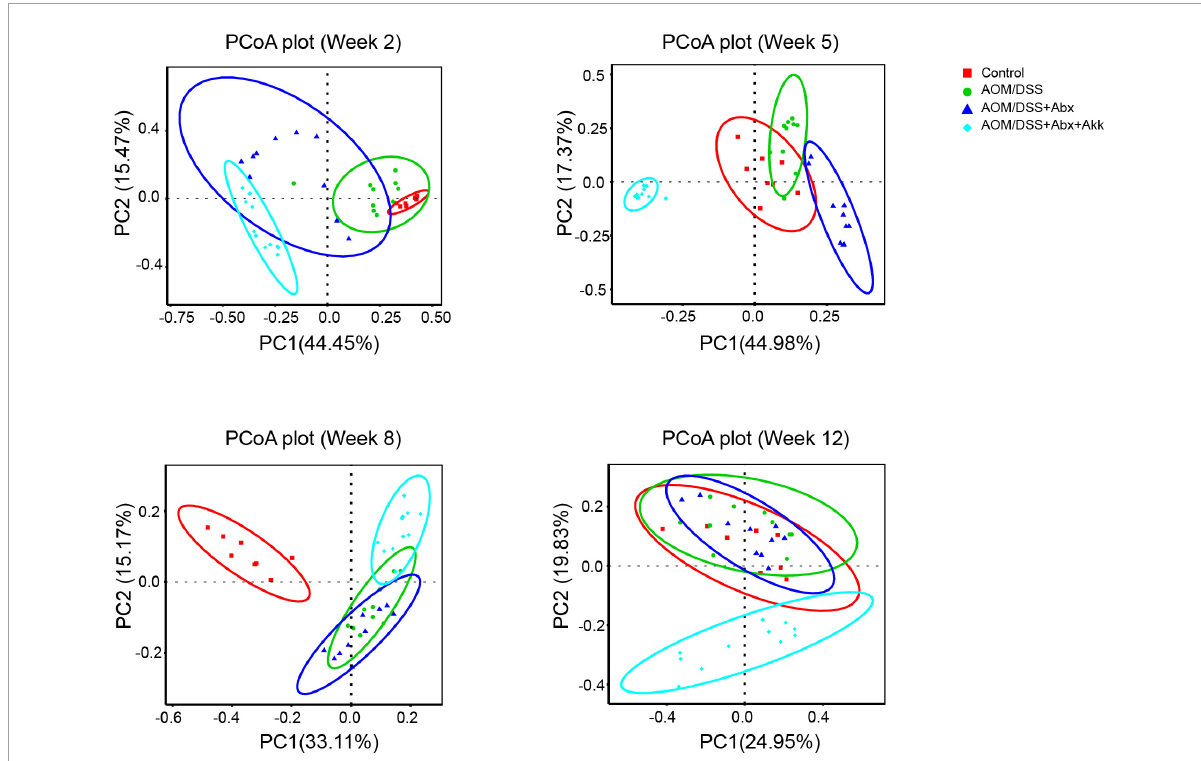
FIGURE5 Post-antibiotic administration of Akkermansia muciniphila reshaped microbial reconstruction during tumorigenesis. PCoA plot based on Bray-Curtis distance showing the evolution of the gut microbial structure during the development of tumorigenesis in the Control,